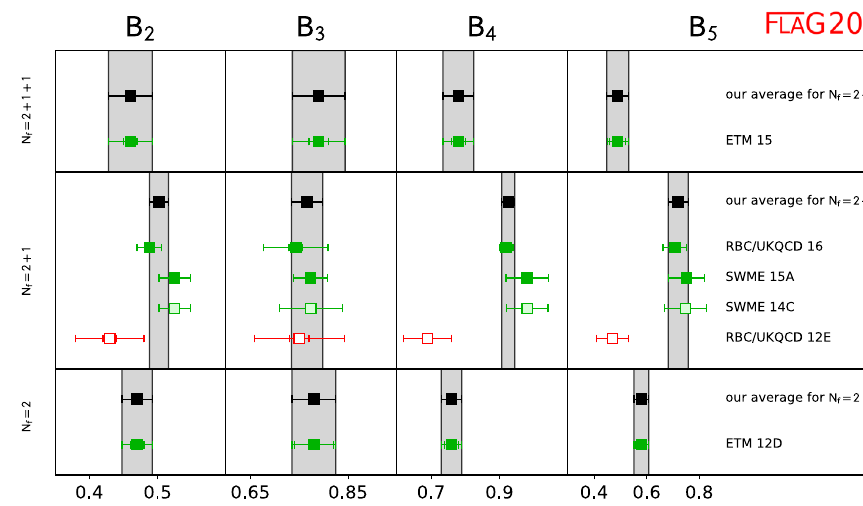
Fig. 21 Lattice results for the BSM B -parameters defined in the MS scheme at a reference scale of 3GeV, see Table